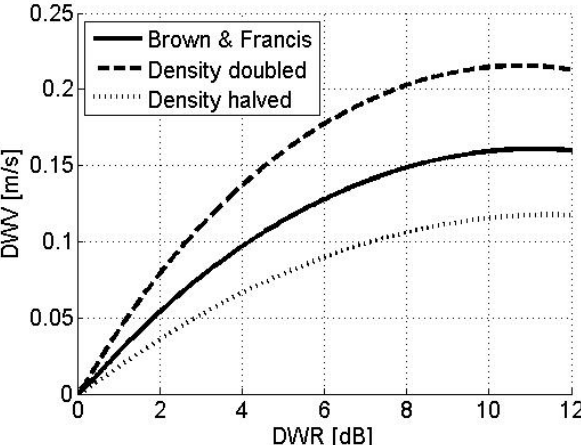
Figure 12. Difference in mean Doppler velocity DWV as a func- tion of dual-wavelength reflectivity ratio, DWR. The thick solid line shows the prediction for the Brown and Francis density relationship, while the thinner dashed lines show the effect of doubling or halving the density of the particles.